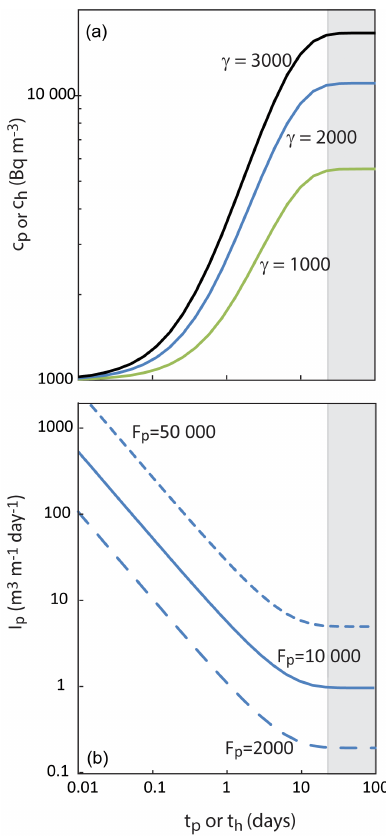
Figure 3. (a) Variation in the 222 Rn activity in the parafluvial or hyporheic zone ( c p or c h ) with residence time ( t p or t h ) and 222 Rn emanation rate ( γ ) (Eq. 3). (b) Variation in the water flux from the parafluvial zone ( I p ) with the flux of 222 Rn from the parafluvial zone ( F p ) and t p (Eq. 5). In both cases c r = c in = 1000Bqm − 3 .